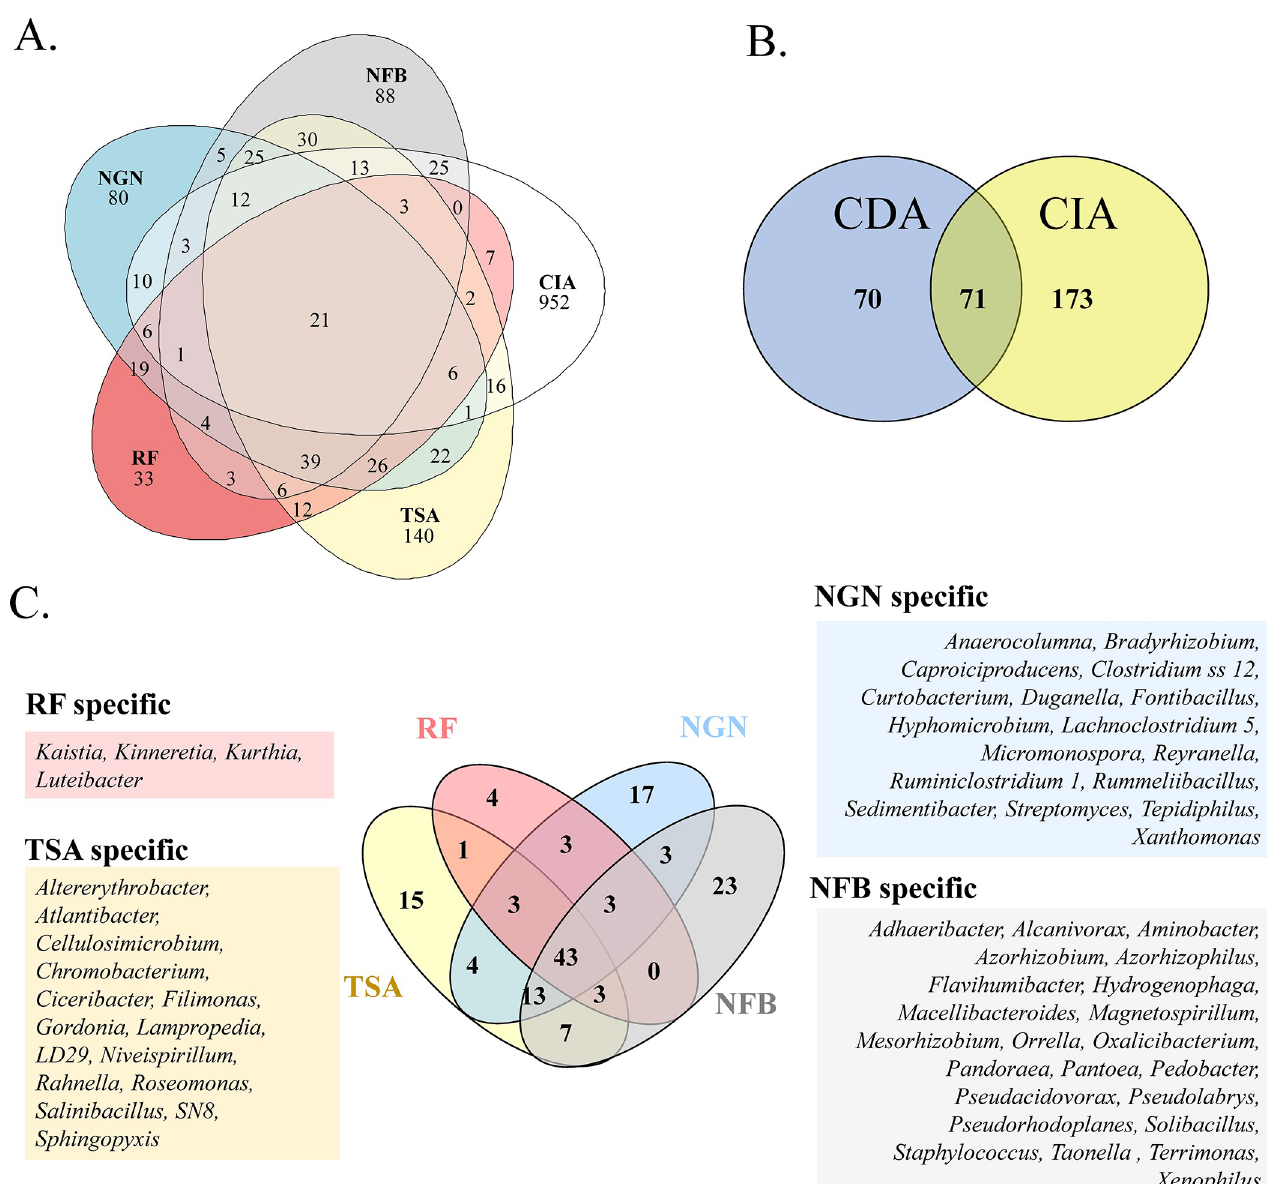
Fig 4. Venn diagrams of the diversity between CDA and CIA. Venn diagrams were produced at the ASV level (A), genus level (B), and between culture media used for the CDA (C). Specific genera obtained on a given culture medium are listed in (C). used two different analytical methods to infer operational taxonomic units, i.e. ASV (based on exact sequence variant detection, [12] or OTU (based on clustering by swarming, [11]). As ASV analysis detected more diversity than OTU at different levels (even class and order levels, Table 1), we preferred to use ASV for all subsequent diversity and functional predictions. As exact sequence variants highly rely on algorithms for sequencing error detection and correc- tion, we could not exclude that some of the obtained diversity was due to algorithm imperfec- tions. However, given that the obtained higher diversity also concerned higher taxonomic levels, this artificial diversity issue is unlikely as it would involve a high number of mutations.